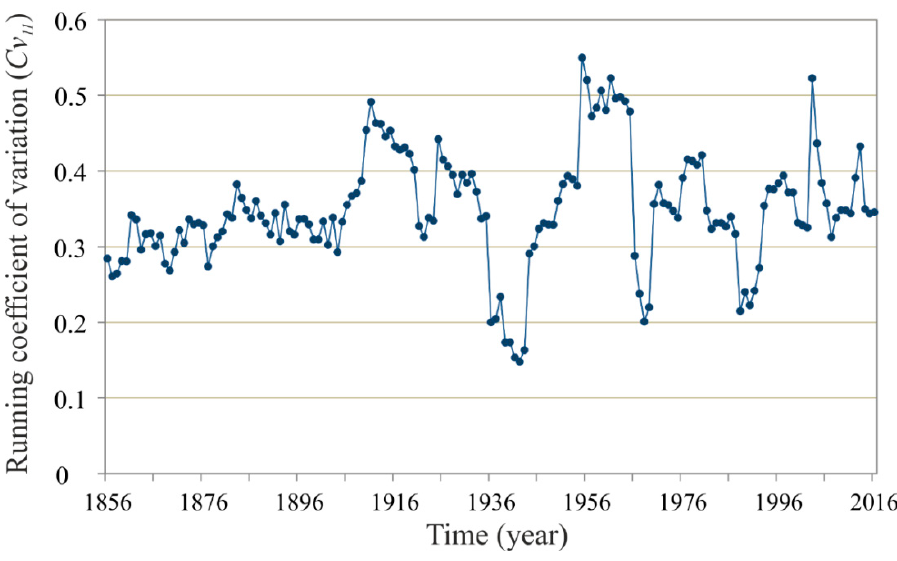
Figure 4. Evolution of 11-year running coefficient of variation ( C ν 11 ).